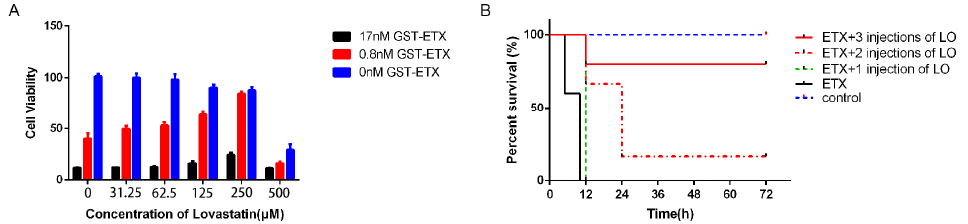
Figure 8. Lovastatin (LO) inhibits the toxicity of ETX. ( A ) MDCK cells were incubated with LO for 30 min, and then exposed to ETX for 1 h. The cytotoxicity of ETX was measured by MTS assay. ( B ) Mice were injected with 6400 ng/kg ETX 30 min after the administration of a first, second, or third dose of LO. Mice in the control group were injected with PBS.